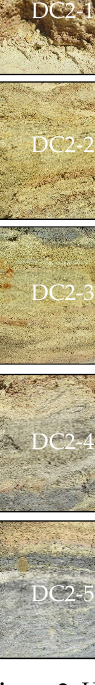
Figure 2. Horizontal profiles in DC2 dam.